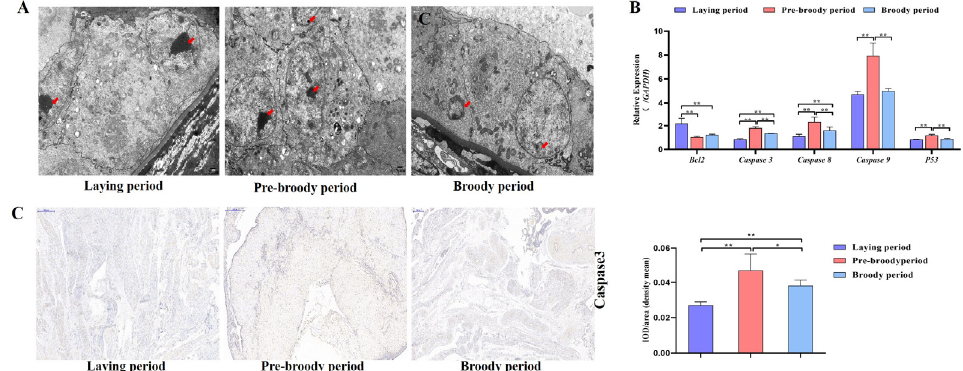
Figure 5. Changes in apoptotic goose ovaries during each period. ( A ) Apoptosis of GCs during the laying, pre-broody and broody periods observed by electron microscopy. Scale bar = 2 µ m. Red arrowheads: nuclear chromatin condensation, nuclear chromatin margination. ( B ) RT–qPCR analysis of the mRNA levels of Bcl-2 , Caspase-3 , Caspase-8 , Caspase-9 and P53 in the ovaries of geese during different periods. All the data are expressed as the means ± standard deviations of 3 independent experiments and were normalized to GAPDH . ( n = 3); * p < 0.05; ** p < 0.01. ( C ) Immunohistochemical staining of Caspase-3 and quantitative analysis of immunohistochemical staining of Caspase-3 based on the mean density. Scale bar = 200 µ m. All the data are expressed as the means ± standard errors of 3 independent experiments and were normalized to GAPDH ( n = 3); * p < 0.05; ** p <